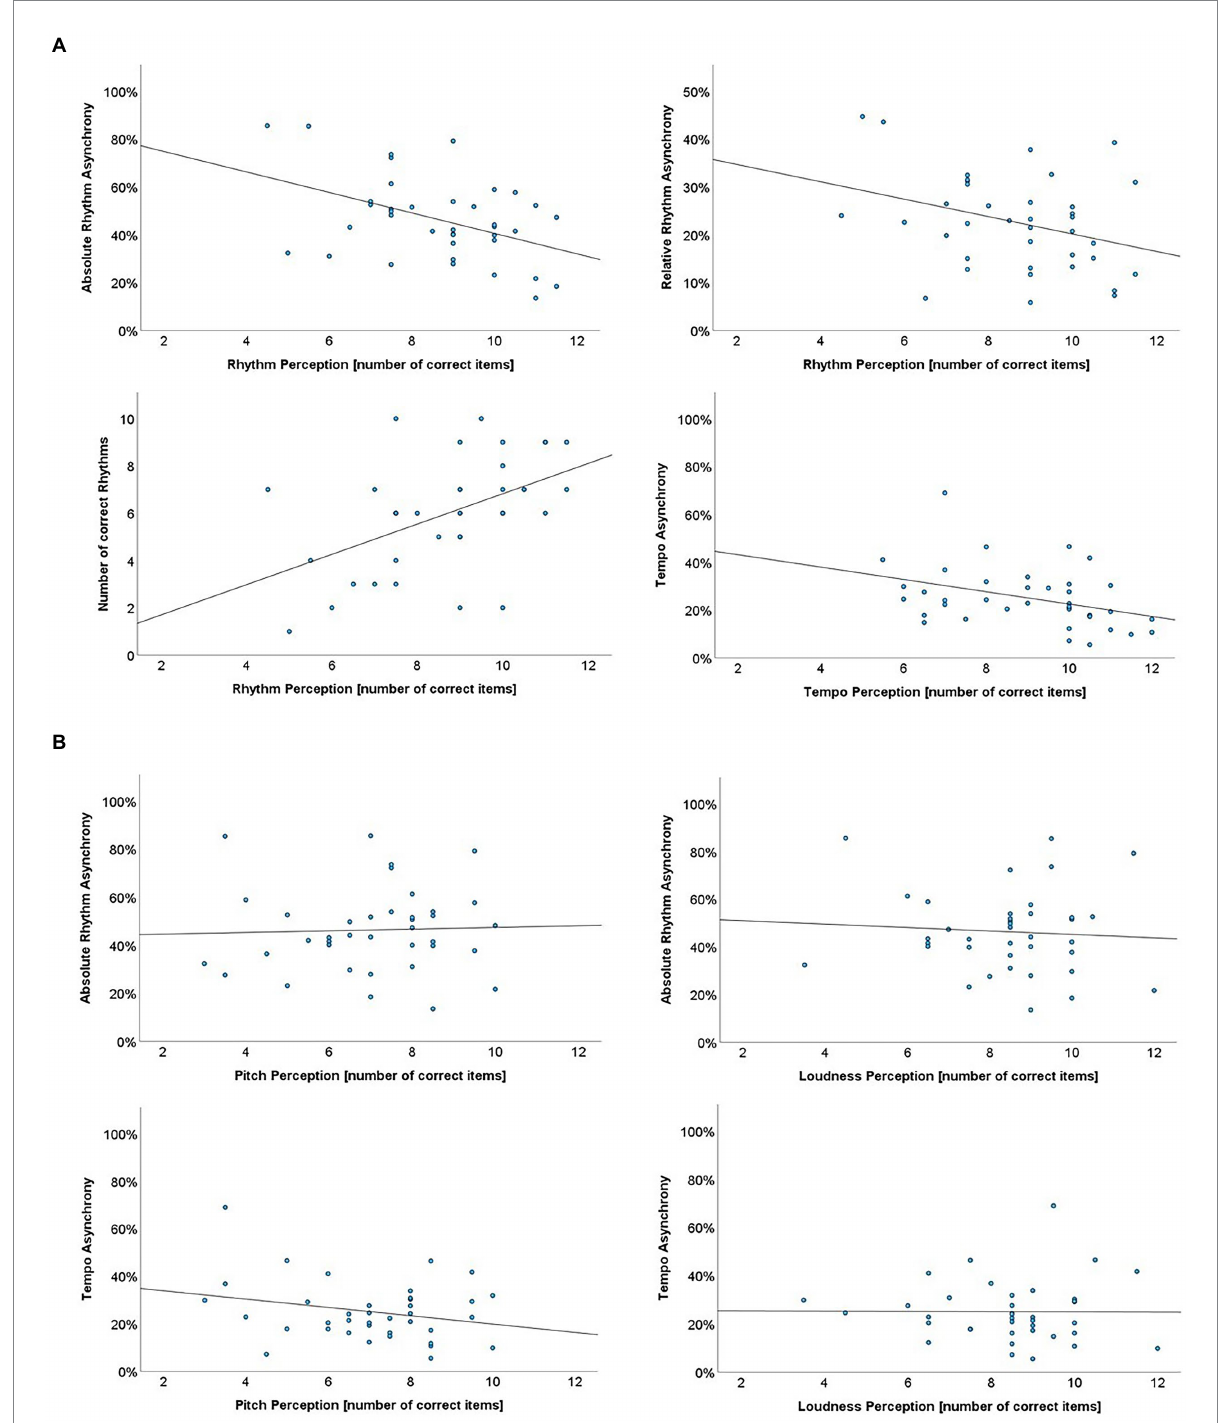
FIGURE 3 (A) Scatterplot visualization of the relationship between performance on rhythm and tempo reproduction tasks with performance on the respective corresponding perceptual tasks. (B) Scatterplot visualization of the relationship between performance on rhythm (absolute rhythm asynchrony) and tempo reproduction tasks with performance on the non-temporal perception